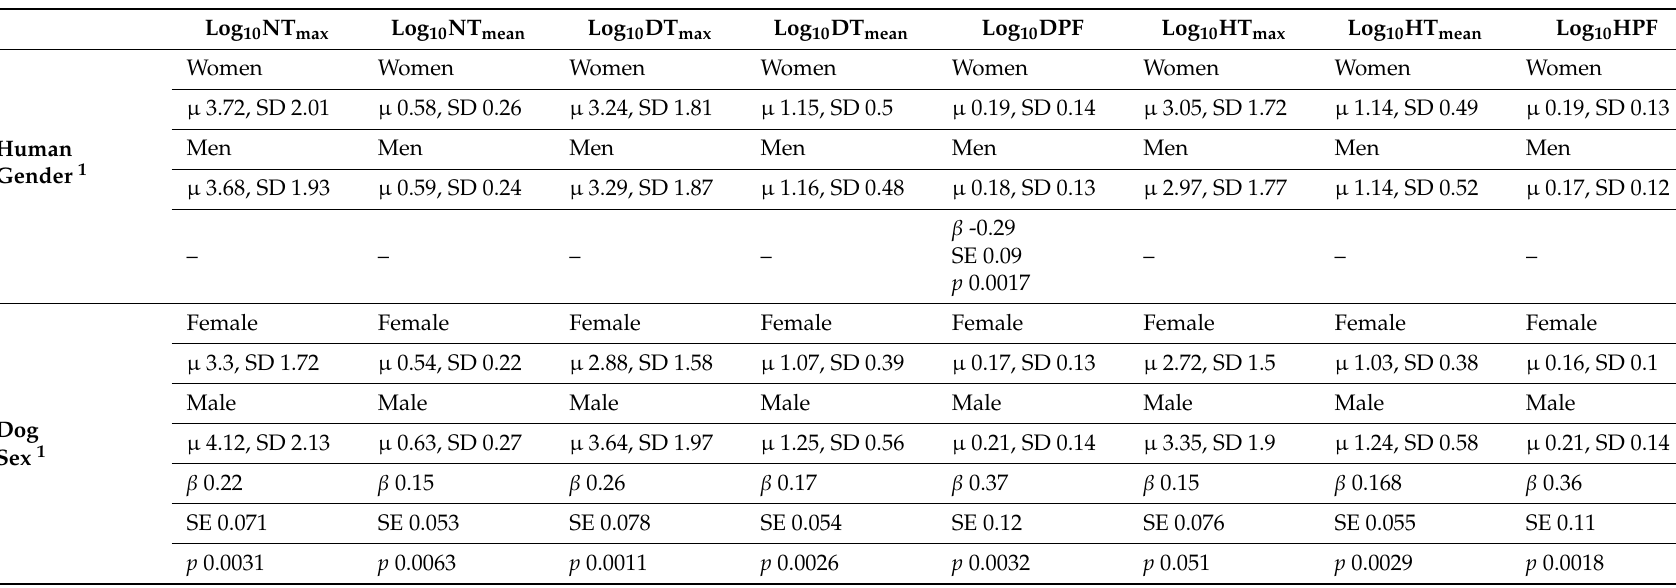
p 0.0031 p 0.0063 p